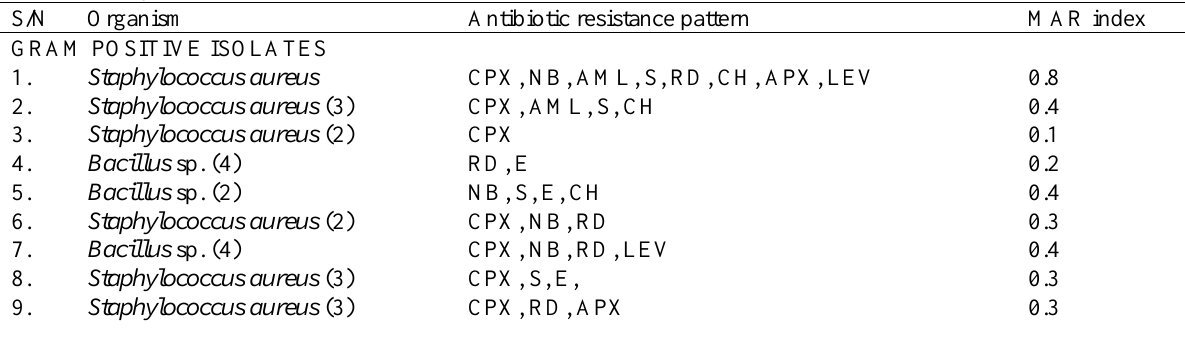
Fig. 4. Resistance pattern to applied antimicrobial classes Table 2. Multiple antibiotic resistance index of bacterial isolates